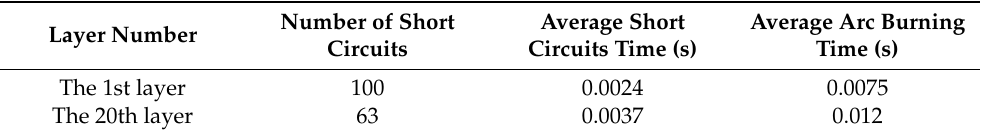
Table 4. Cladding characteristics at the 1st and the 20th layers.